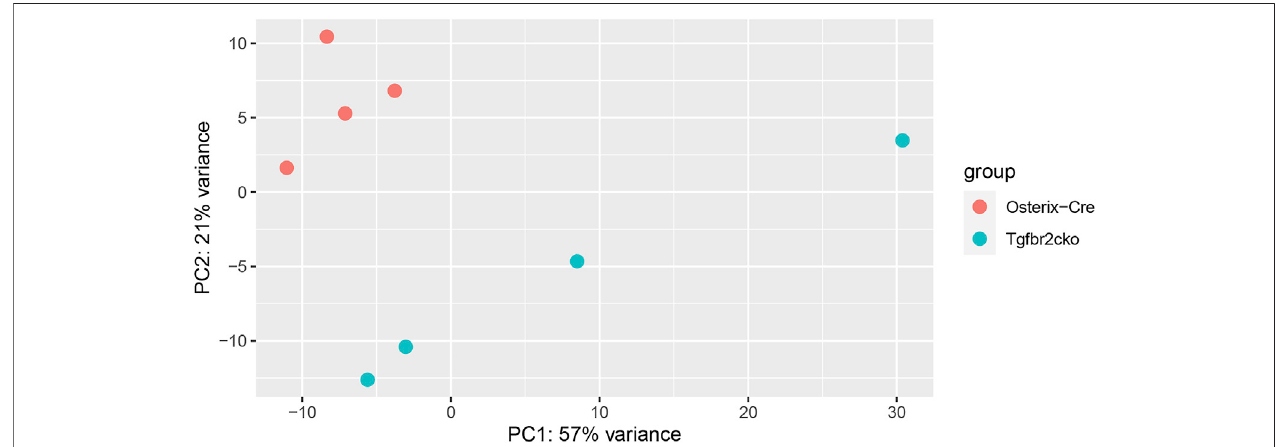
FIGURE 4 | Results of principal components analysis (PCA) of RNA-Seq data from Osterix-Cre and Tgfbr2 cko DP at P7 for all samples used in this study.